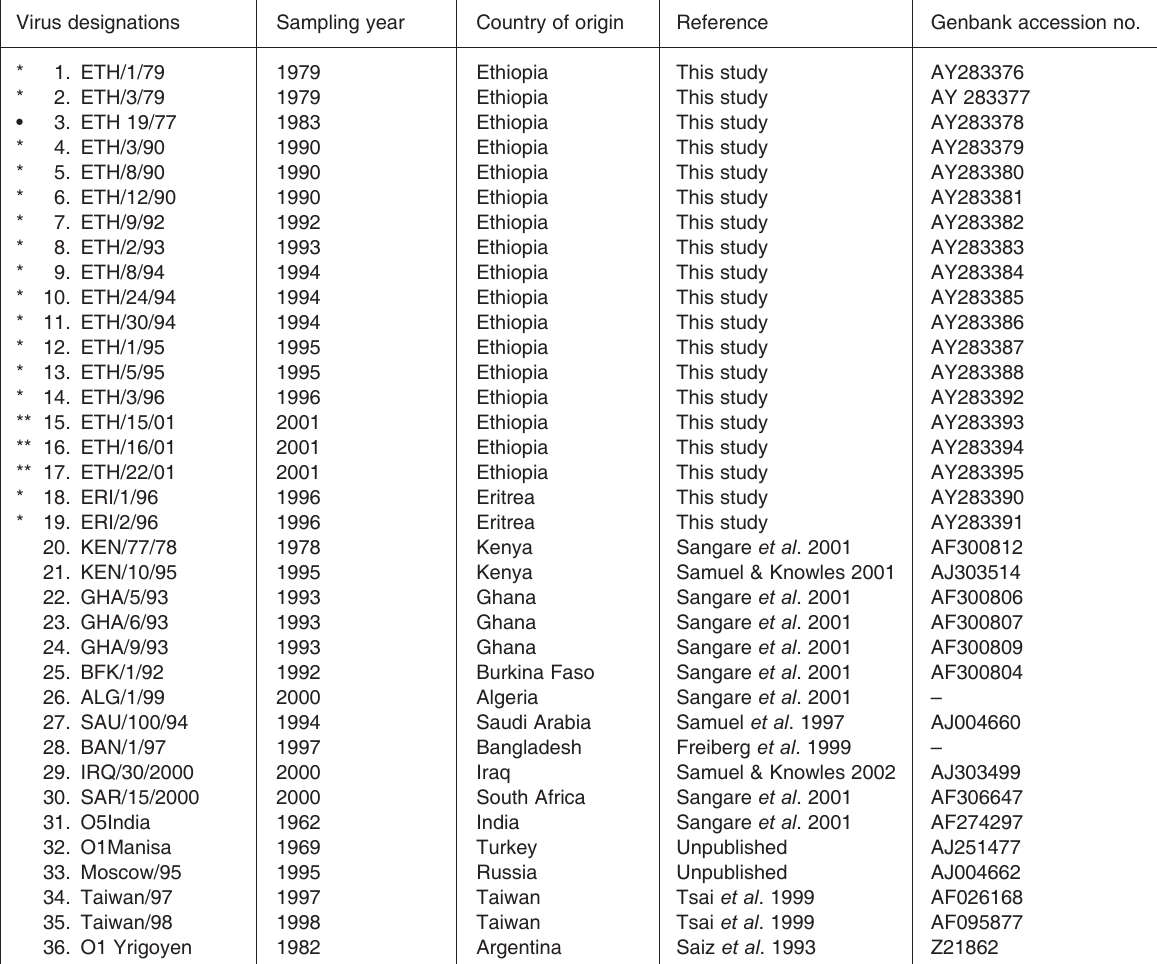
TABLE 1 Summary of serotype O foot-and-mouth disease viruses included in this study and that were compared with those pub- lished in the literature Virus